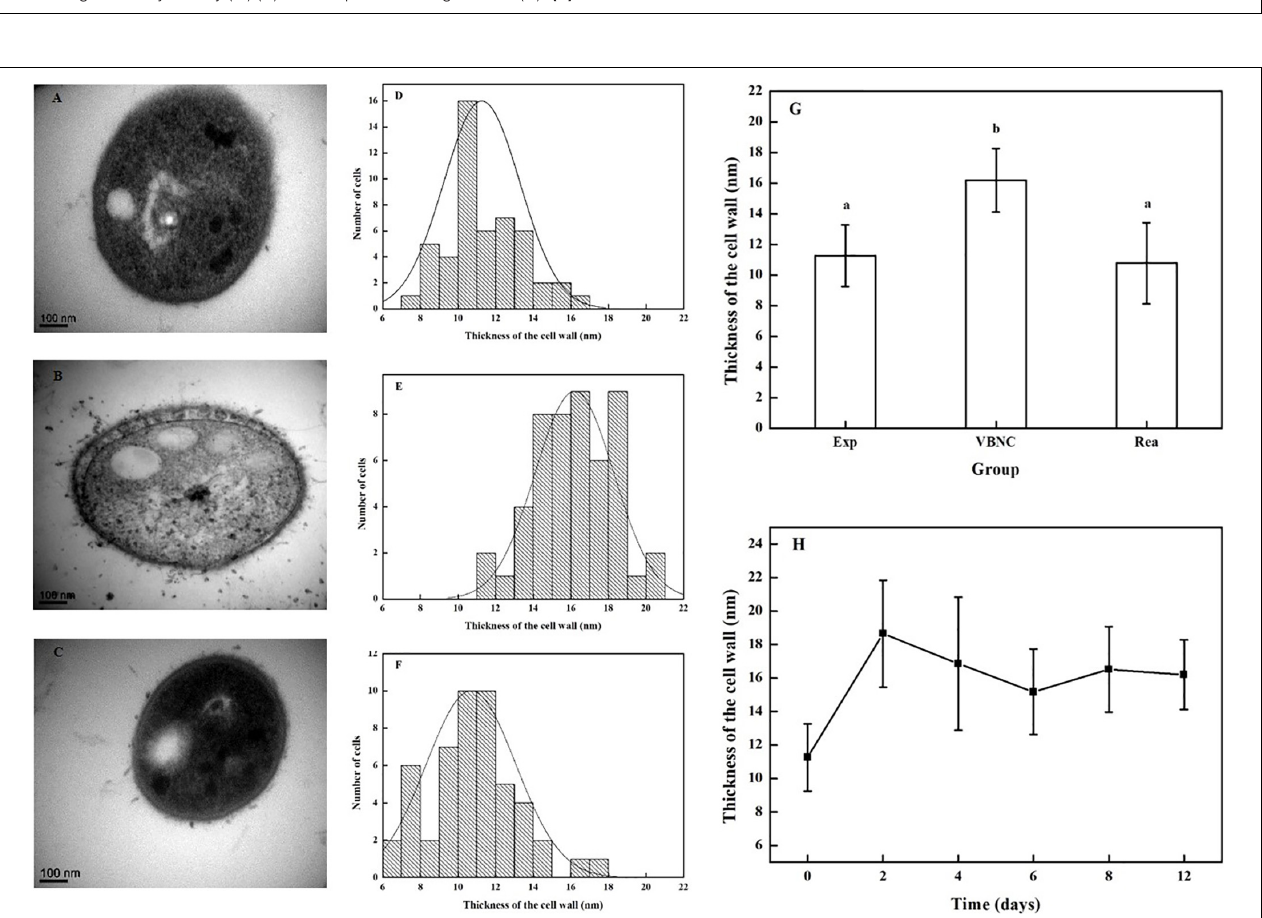
FIGURE 1 | Induction and resuscitation of R. biphenylivorans TG9 cells in the VBNC state. (A) Entry into the VBNC state induced by treatment with norfloxacin, according to flow cytometry ( (cid:4) ) ( O ) and the plate counting method ( (cid:78) ). (B) Resuscitation of VBNC cells.